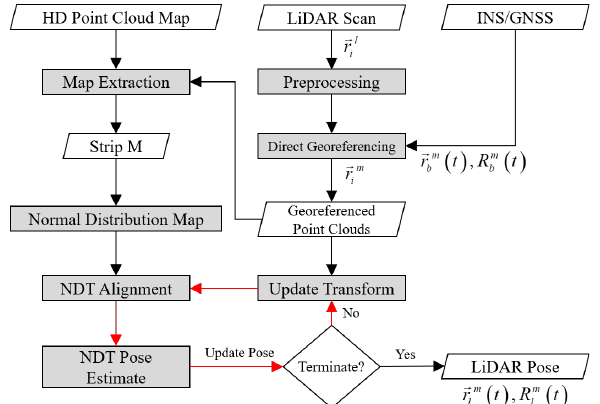
Figure 2 . Workflow of proposed LiDAR scan matching